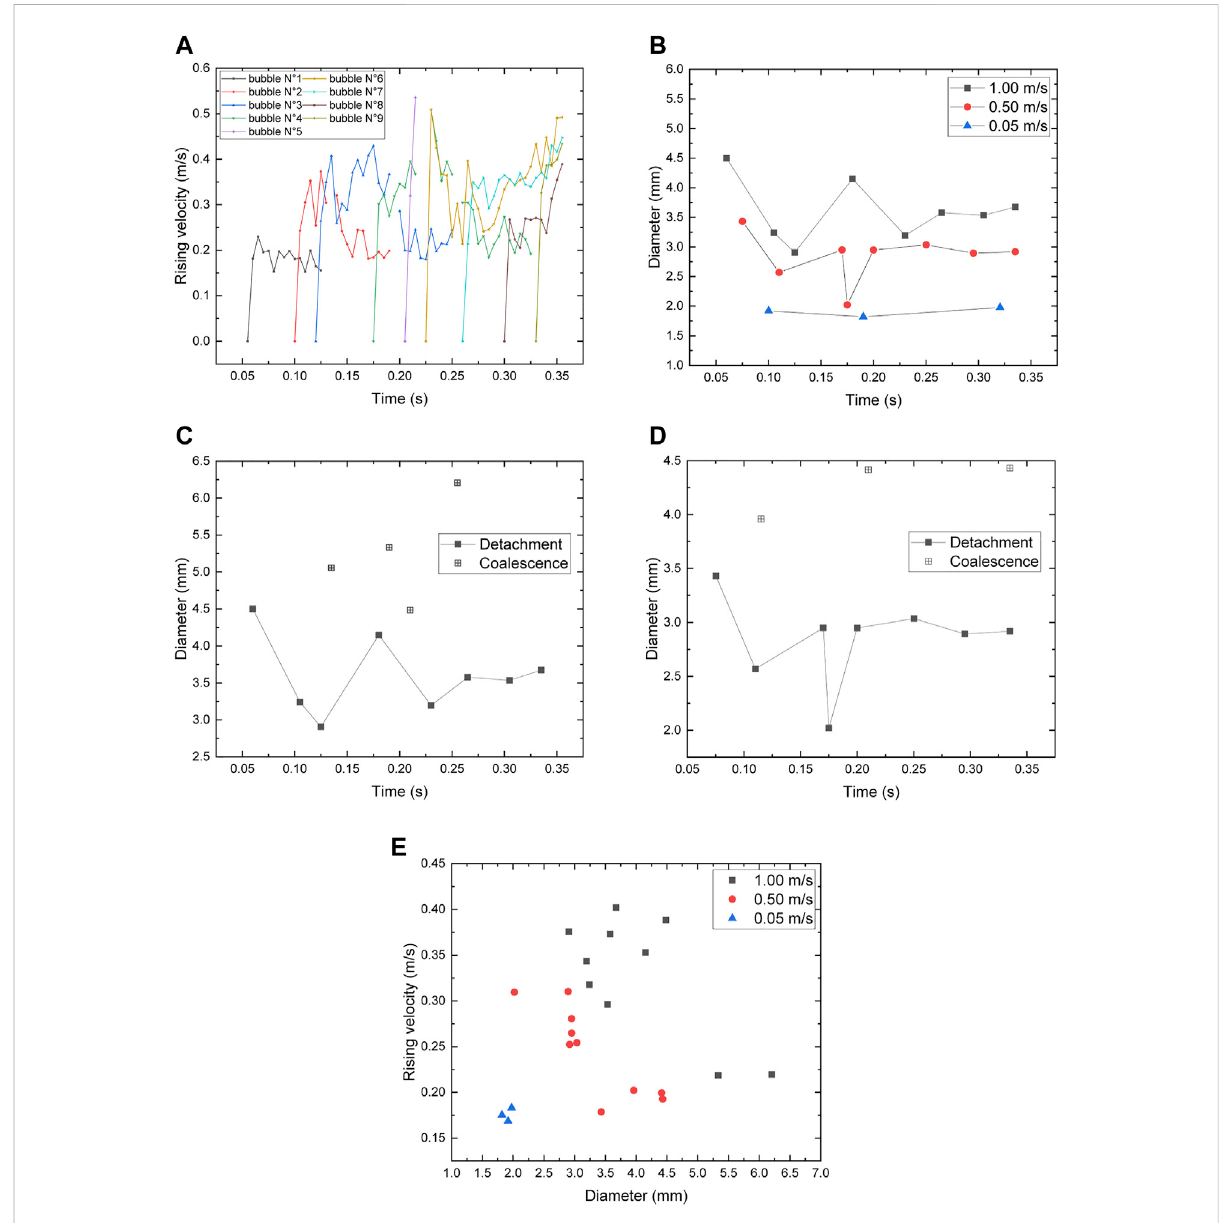
FIGURE 12 Release and migration behavior the bubbles generated by gas injection at the wall ori fi ce in molten LBE. (A) Instantaneous rising velocity. (B) Equivalent diameter. (C) Equivalent diameter, v o = 1 m/s. (D) Equivalent diameter, v o = 0.5 m/s. (E) Terminal rising velocity.